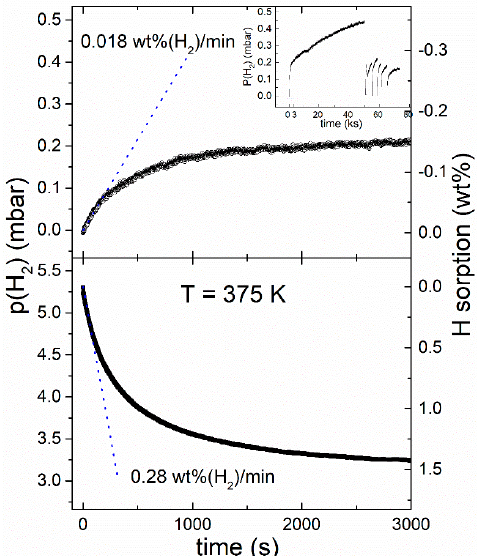
Figure 4. Hydrogen desorption ( top ) and absorption ( bottom ) for Ti 15 atom % NPs at 375 K. Sorption rates obtained by linear fits (dotted blue lines) of the initial data are shown. Several consecutive desorption steps are shown in the inset, to demonstrate that the slowdown in the kinetics is to be ascribed to p des approaching.